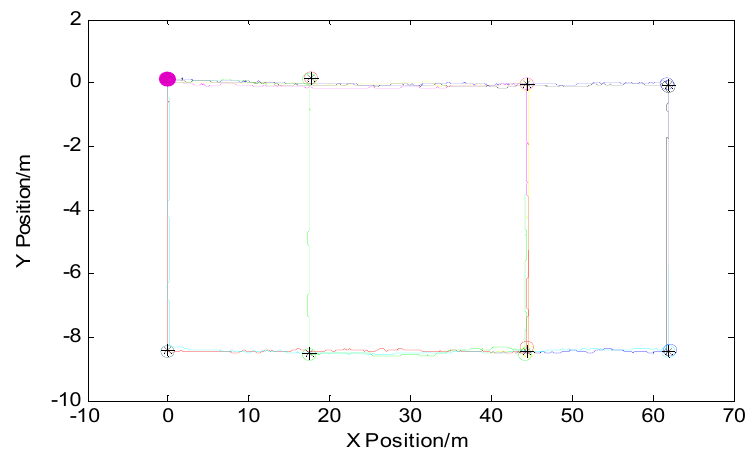
Figure 6. Feature points map.